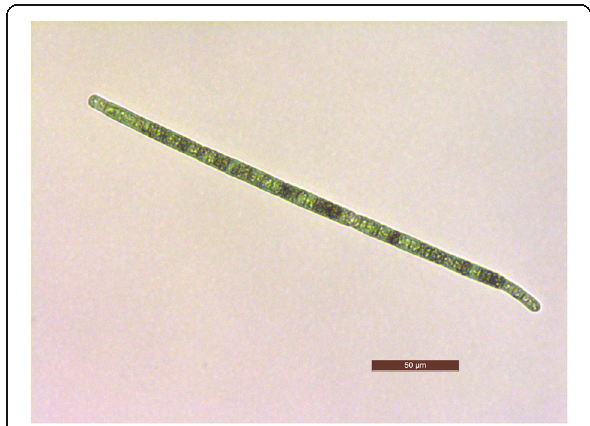
Fig. 1 Photomicrograph of a trichome of Planktothricoides sp. SR001 under bright field and 40× magnification. Cell attenuation was observed at the end of trichome